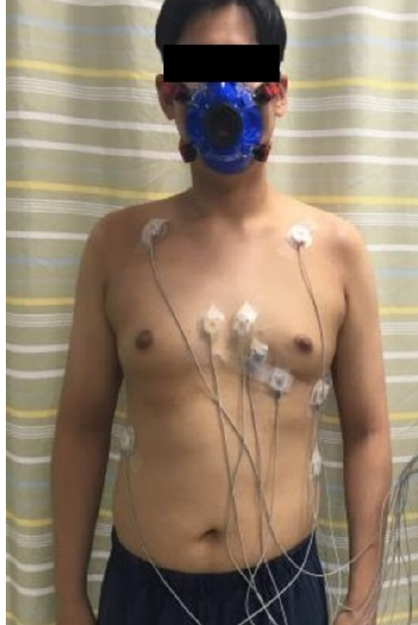
Figure 2. Location of electrocardiogram electrodes .